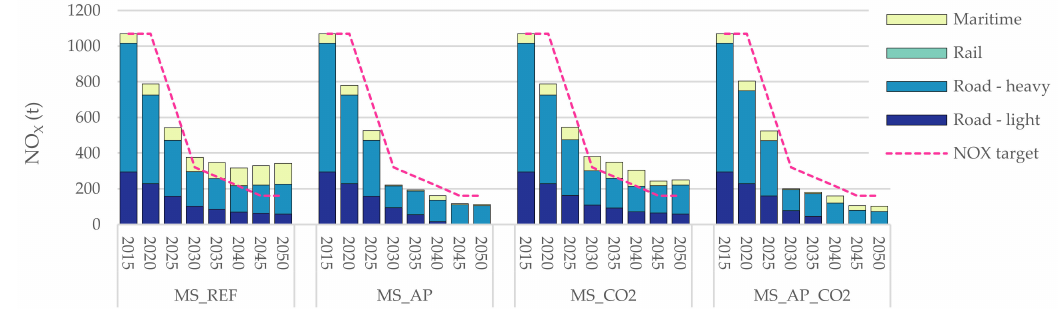
Figure A7. By-mode tailpipe emissions of nitrogen oxides (NO X ) in the mode shift (MS) scenarios (t). Note : Road—heavy = buses, MGVs and HGVs; Road—light = cars and LCVs.